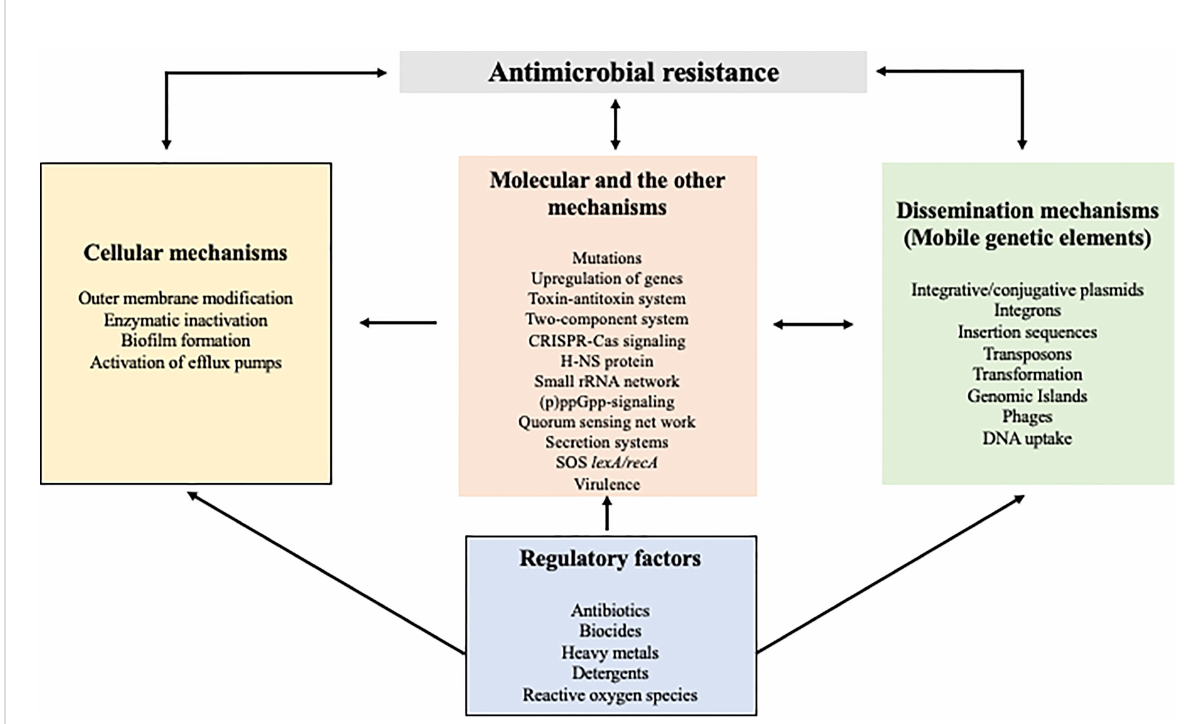
FIGURE 1 Common mechanisms and their interaction in the dissemination of antimicrobial resistance. As shown in different boxes, cellular and molecular mechanisms as well as mobile genetic elements are responsible for the acquisition and dissemination of AMR. The regulatory factors that prevail in the environment directly or indirectly in fl uence many of the AMR